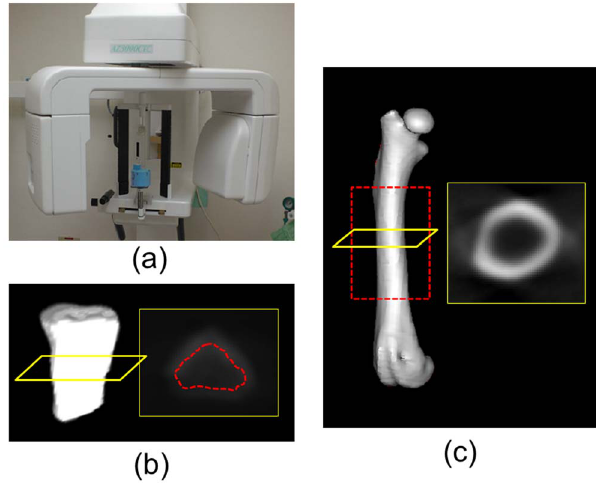
Figure 2. Dental CT machine, images and 3D renderings. (a) Dental CT machine (Asahi AZ 3000), (b) hemi 5th lumbar vertebral body (excluded the posterior element) in left, the section of the dental CT image in right (the region of interest for trabecular bone calculated also shown in dotted red line), and (c) intact femur (the region of interest for cortical bone calculated also shown in dotted red line) in left, the section of the dental CT image in right.